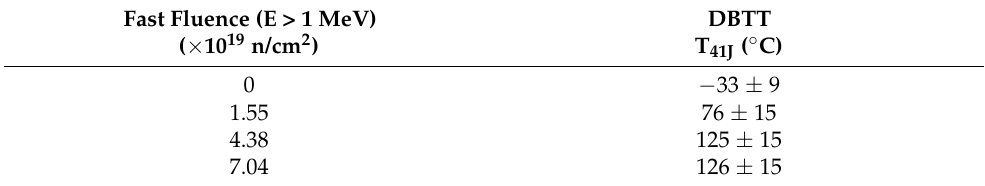
Figure 2. The scattering of the Charpy impact test measurements and the fitted ductile to brittle transition temperature curve that fades the specimens’ inhomogeneities in the case of A508 Cl.2, and of 15Kh2NMFA type material. Table 3. Fast fluence (E > 1 MeV) and DBTT for A508 Cl.2 material.